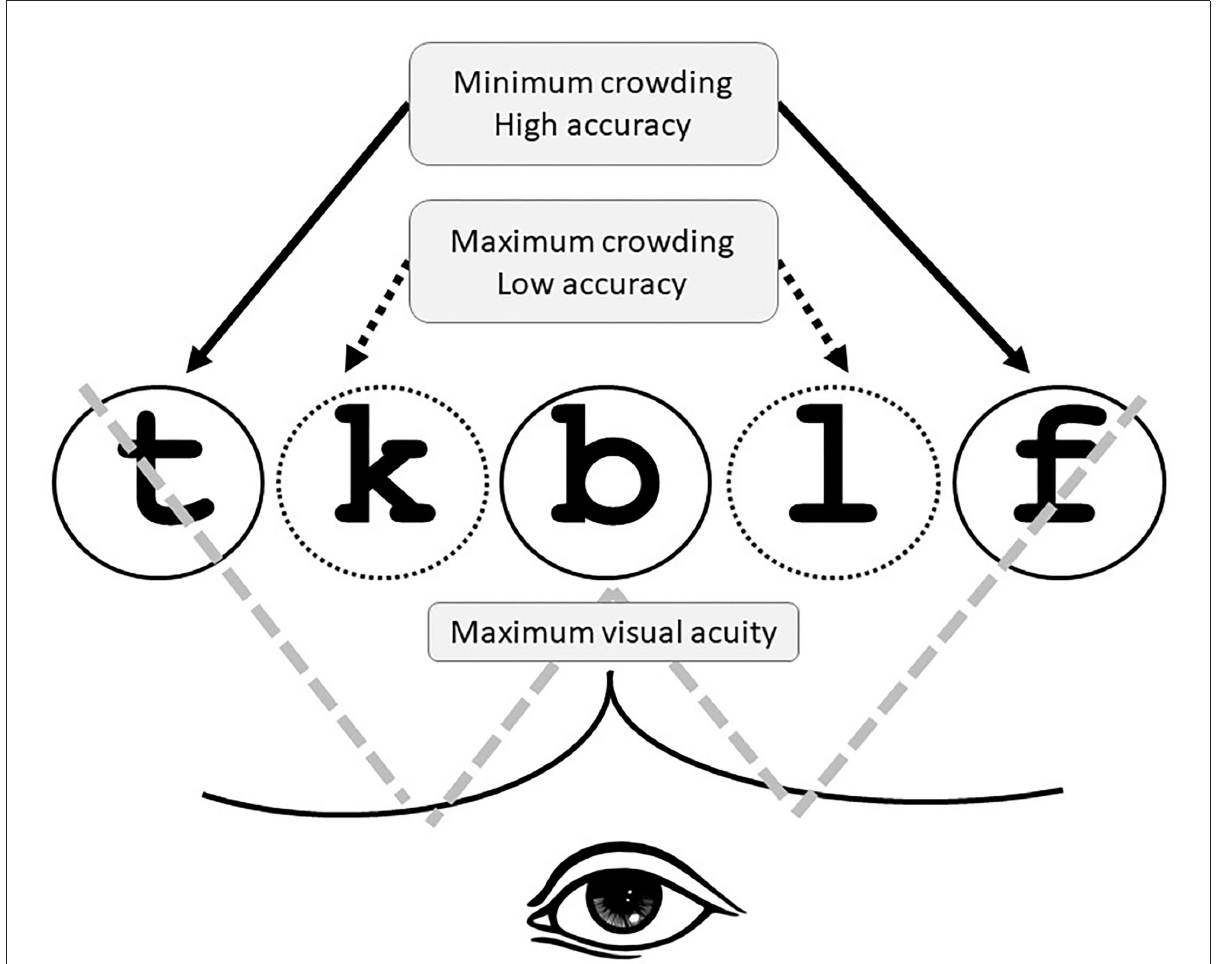
FIGURE1 Illustration of the serial position function in the identification of the letters within the string of